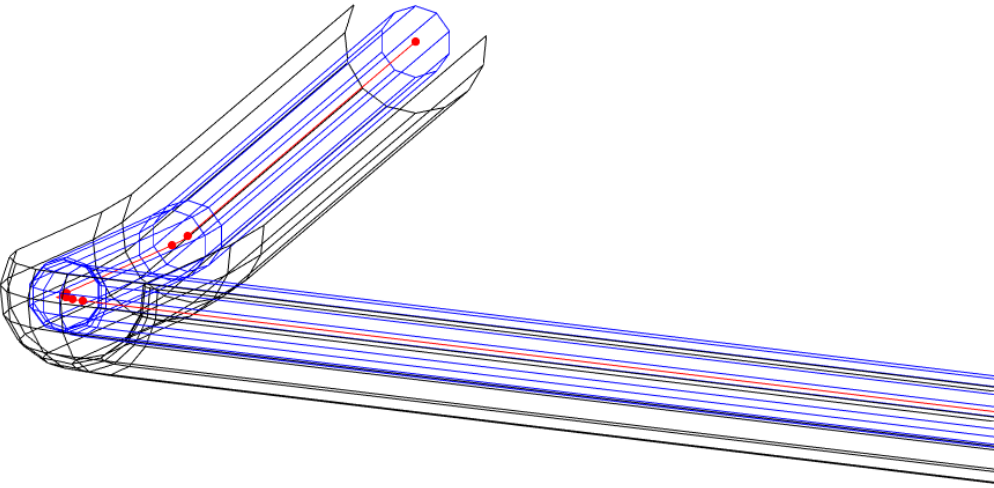
Figure 10. Generation of a ditch model (black) surrounding the pipe (blue) generated for an underground network object